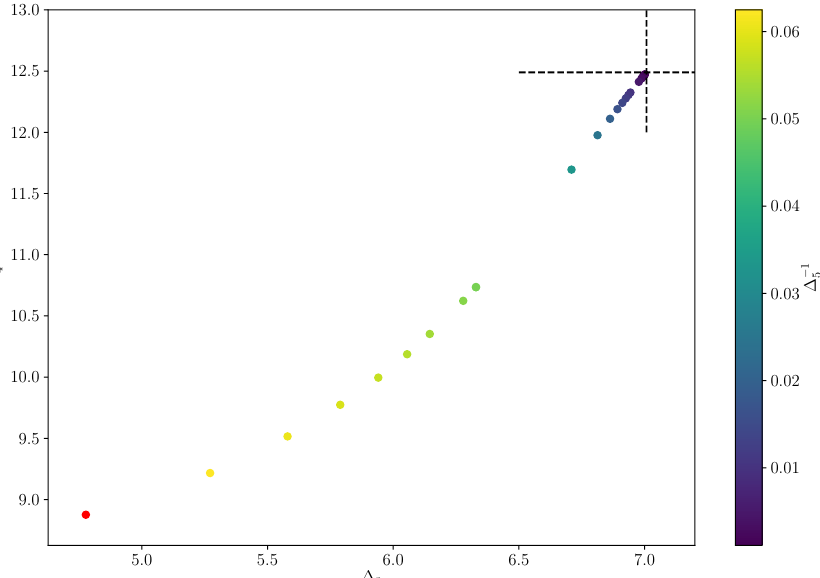
) where the first two are fixed , ∆ , ∆ 3 4 5